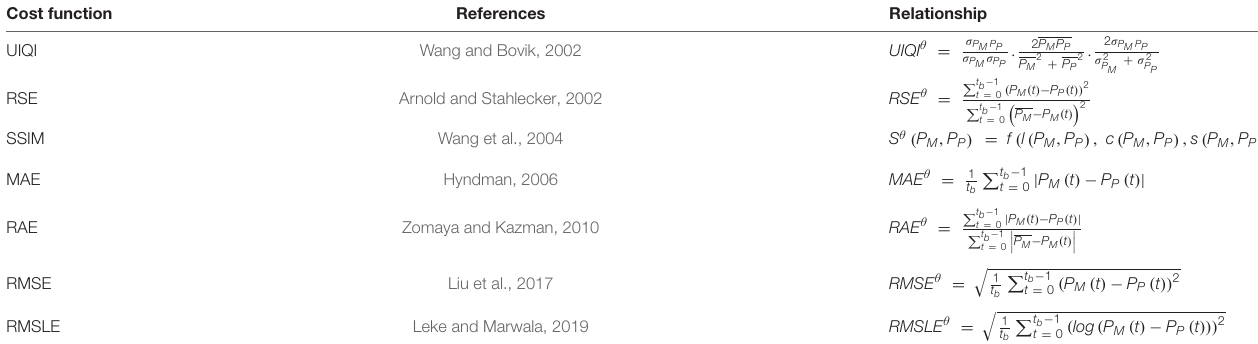
TABLE 1 | Cost functions used for image reconstruction and their mathematical relationship for θ th view. Cost function